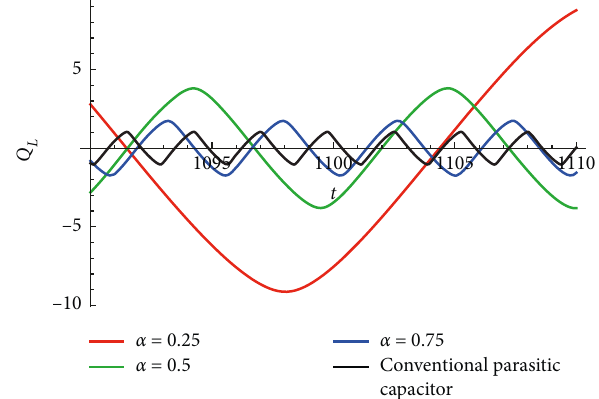
Figure 16: Q L vs t of the memristor-inductor circuit with the nonlinear parasitic fractional capacitor/nonlinear conventional parasitic capacitor.